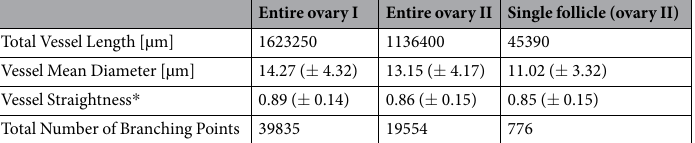
Table 1. Numerical parameters calculated from the filament analysis. * The vessels straightness parameter is a measure of the curvature of the vessel and it is calculated by dividing the distance between two branching points by the length of the filament so a straight vessel will have the value of 1. ** Numbers in brackets indicate standard deviation